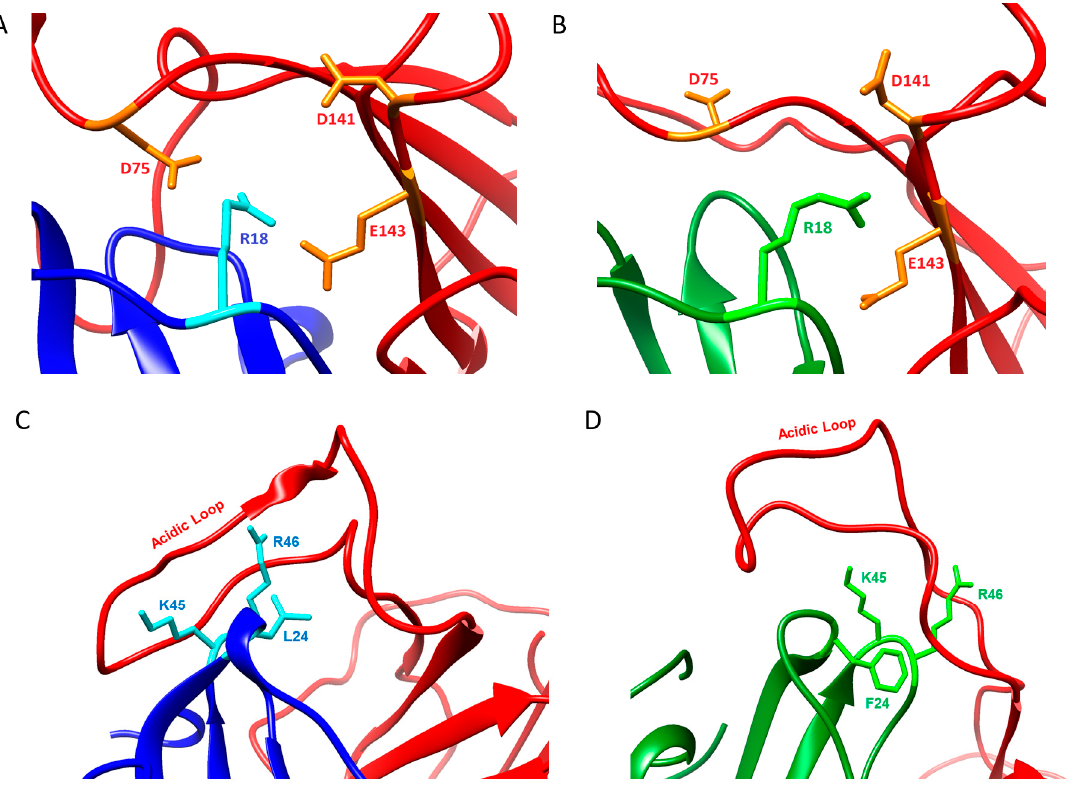
Figure 6. Interactions between vCCI and vMIP-II or MIP-1 β . vCCI is in red ribbon and the bound chemokine is either blue ribbon (vMIP-II) or green ribbon (MIP-1 β ). ( A ) A close-up of the interaction between R18 of vMIP-II (cyan) and D75, D141, E143 of vCCI (orange); ( B ) A close-up of the interaction between R18 of MIP-1 β (bright green) and D75, D141, E143 of vCCI (orange); ( C ) A close-up of the interaction between the β 2 and β 3 loop of vCCI (red) and K45 and R46 of vMIP-II (cyan). L24 of vMIP-II is also indicated in cyan; ( D ) A close-up of the interaction between the β 2 and β 3 loop of vCCI (red) and K45 and R46 of MIP-1 β (bright green). F24 of MIP-1 β is also indicated in bright green.